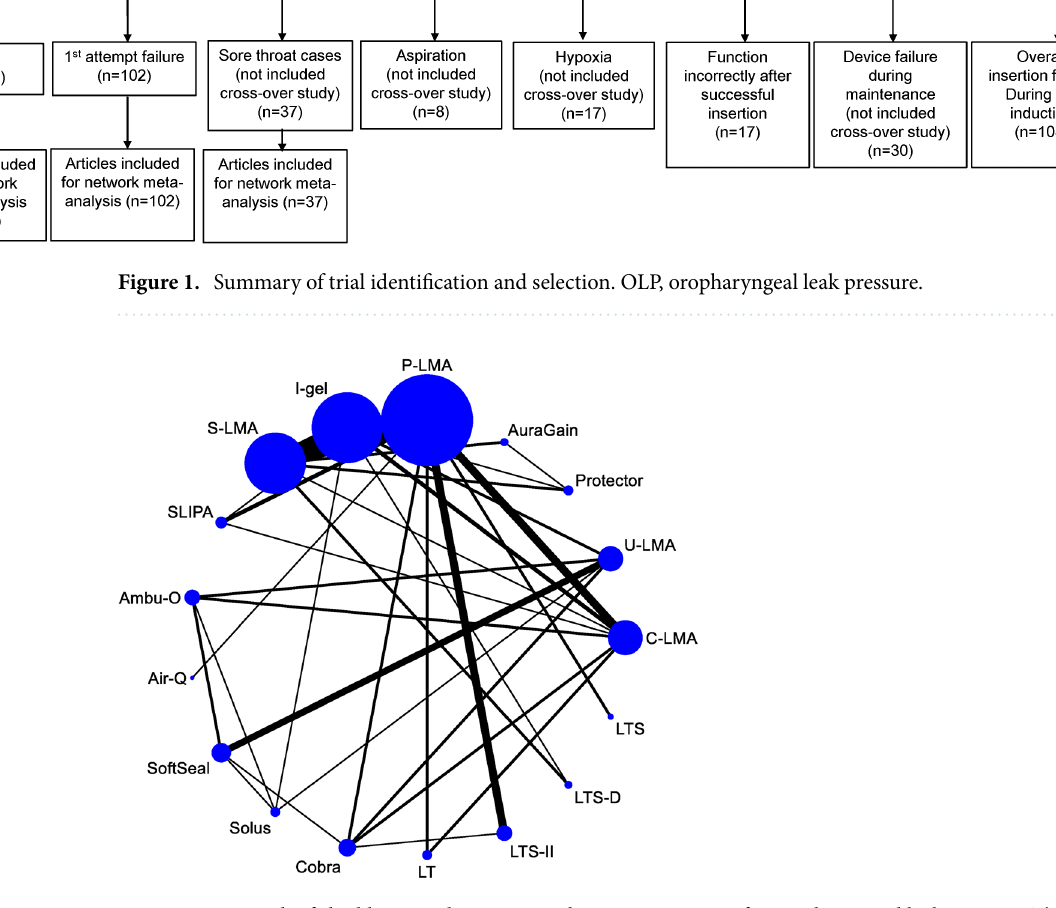
Figure 2. Network of eligible supraglottic airway device comparisons for oropharyngeal leak pressure. The line indicates the number of trials and the dots indicate the number of patients. C-LMA, LMA Classic; U-LMA, Unique LMA; Protector, LMA Protector Airway; AuraGain, Ambu AuraGain Disposable Laryngeal Mask; P-LMA, Proseal LMA; I-gel, I-gel supraglottic airway; S-LMA, Supreme LMA; SLIPA, Streamlined Liner of